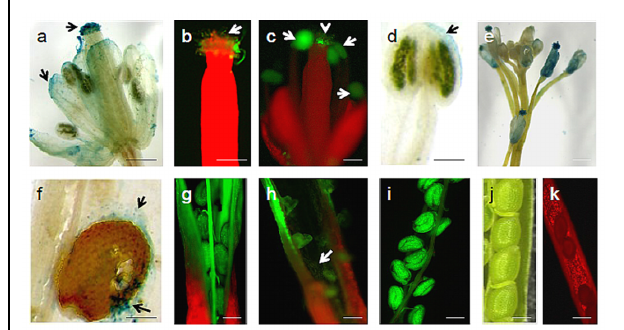
FIGURE 3 | U. virens - Arabidopsis flower interaction. (a) Visible intense GUS histochemical staining on different floral regions of infected Arabidopsis flower by U. virens 3 weeks after post-inoculation; (b) GFP tagged U. virens hyphae growing on the stigma 3 weeks after post-inoculation; (c) GFP-tagged aerial mycelia on the male and female parts of Arabidopsis flower 3 weeks after post-inoculation; (d) U. virens infected male floral structure showing the GUS stain; (e) Colonization of GUS labeled aerial mycelia on the stem, anther, and stigma of the flowers after 3 weeks of post inoculation; (f–i) Mycelium development on siliques and seeds as well as shriveled pod formation from infection of flower tissue 28 days after inoculation with GFP and GUS labeled and transformed strains of U. virens ; (j) Control showing Arabidopsis siliques and seeds; (k) Uninfected Arabidopsis pod under epifluorescence microscopy. Bars = 40 μ m (g–j) , 20 μ m (a–d,f,k) , 150 μ m (e) .